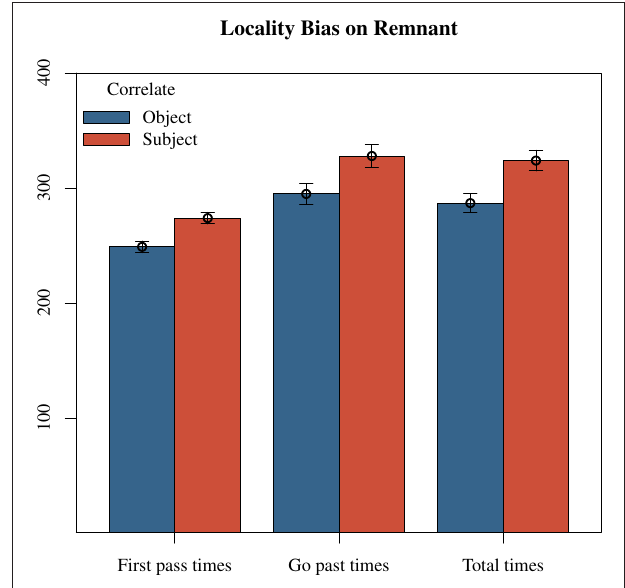
FIGURE 1 | Experiment 2: effect of Locality on the remnant region. Times presented in